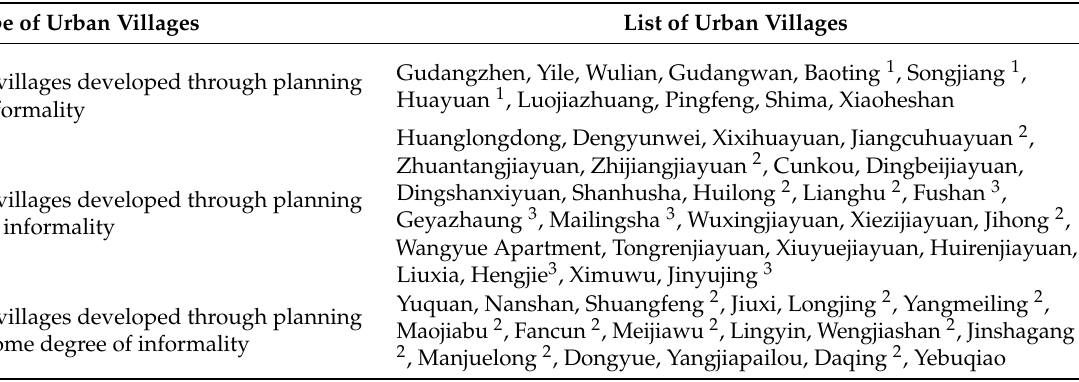
Table 2. List of the urban villages developed through the three policy